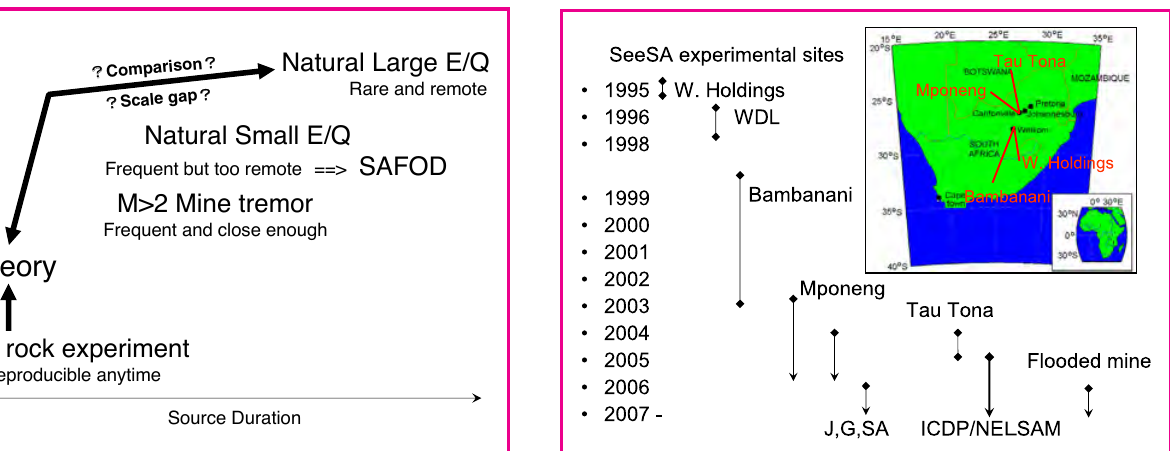
Figure 2. The history of SeeSA experimental sites. Figure 1. The role of intermediate scale